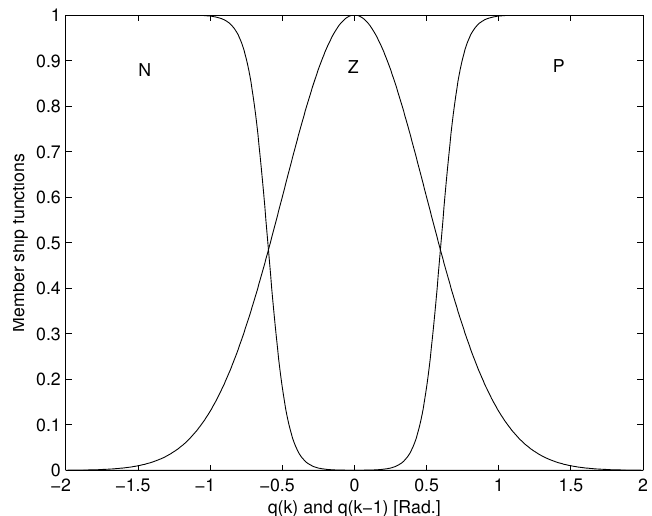
Figure 4. Membership functions of the MiFREN equivalent model: q ( k ) and q ( k − 1 ) .